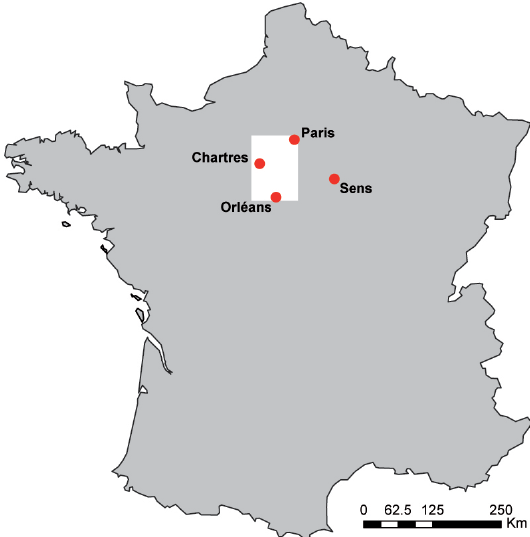
Figure 1. Study area in white, with principle centres in red.